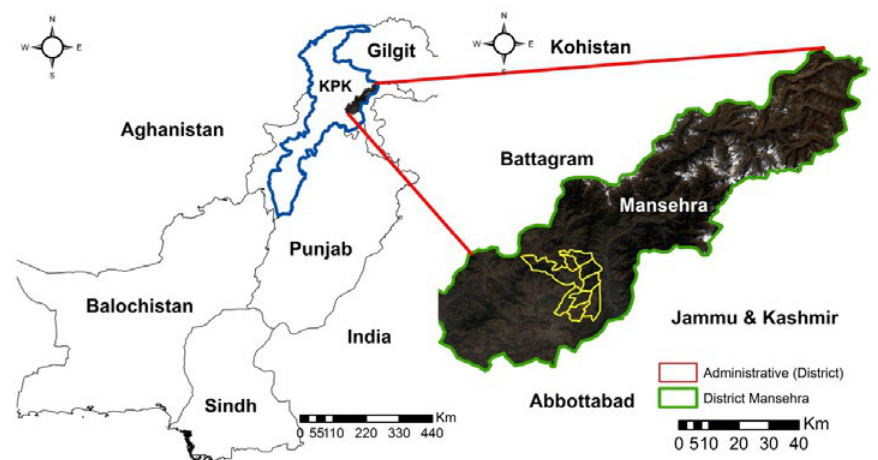
Fig. 1. The geographic location of the study are in district Mansehra,